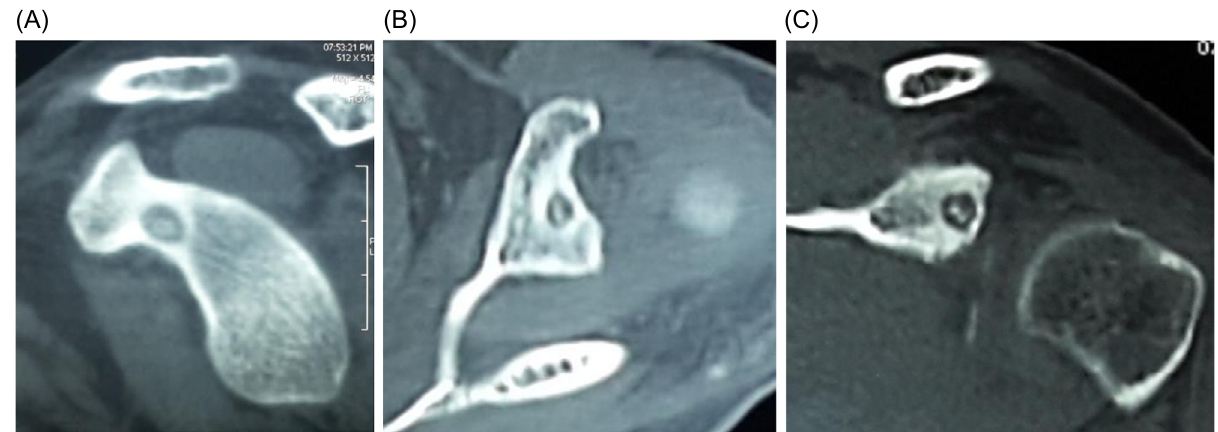
Figure 2. (A–C) CT scan in sagittal, transverse and coronal planes reveals the typical lesion of osteoid osteoma (OO) with a central nidus and surrounding sclerotic bone (to localize lesion pre-operative and plan